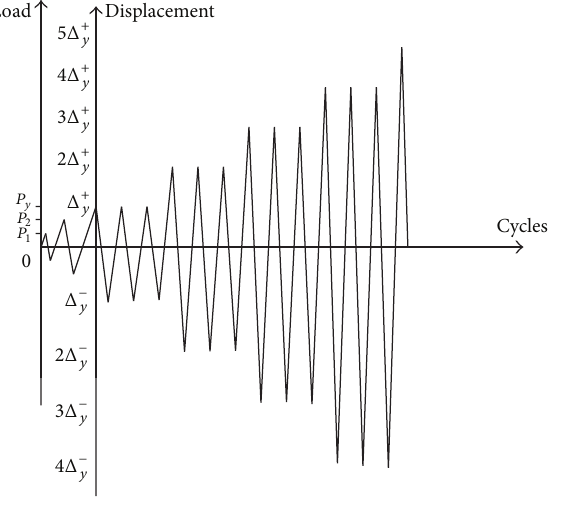
Figure 3: Loading